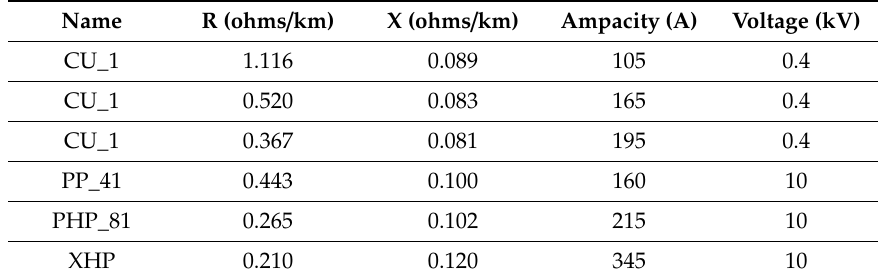
Table A2. Underground cables’